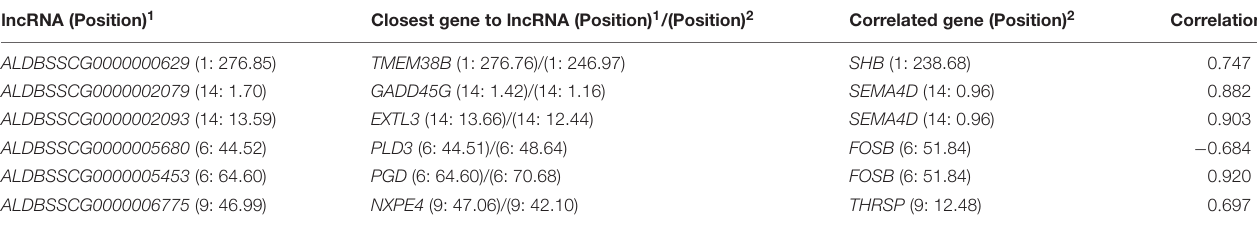
TABLE 5 | Position of lncRNA, closest gene to lncRNA and gene most significantly correlated with lncRNA mapping in the same chromosome. lncRNA (Position) 1 Closest gene to lncRNA (Position) 1 /(Position) 2 Correlated gene (Position) 2